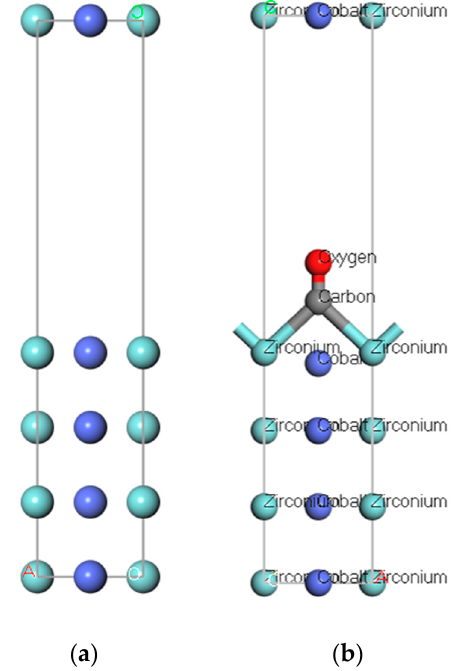
Figure 3. Crystal structures: ( a ) clean model ( b ) CO adsorption model.